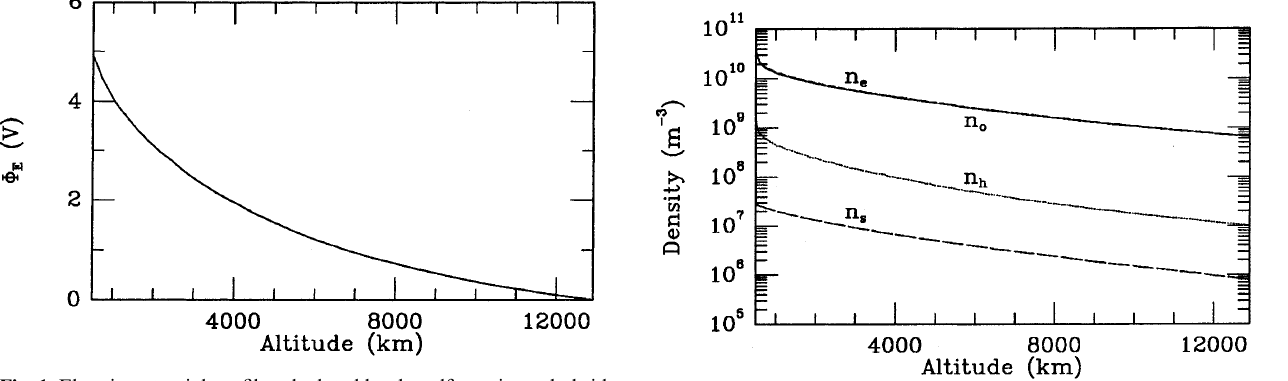
Fig. 2. Calculated density profiles for the O (cid:135) (cid:133) n o (cid:134) ; H (cid:135) (cid:133) n h (cid:134) , thermal electrons ( n e ), and photoelectrons ( n